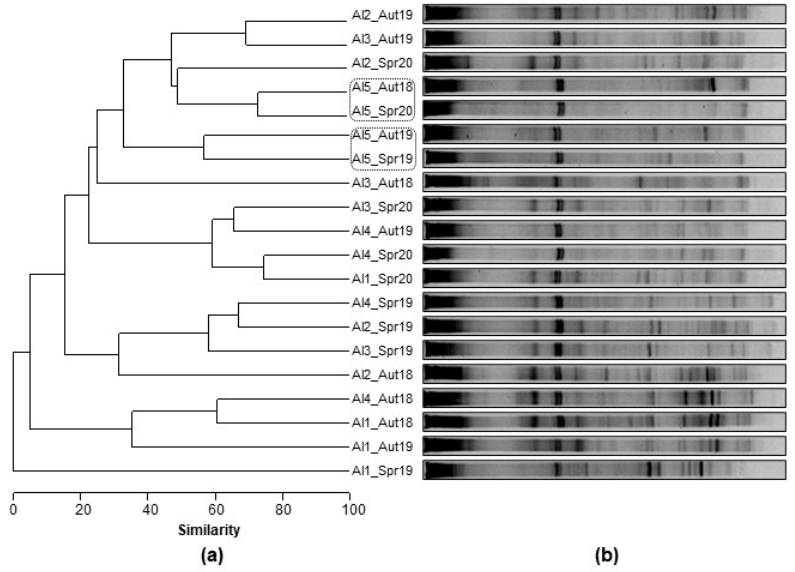
Figure 4. ( a ) Complete linkage dendrogram and ( b ) PCR-DGGE fingerprints of Alqueva (Al) bacte- rioplankton found at each sampling site (Al1, Al2, Al3, Al4, Al5) and sampling period (Aut18; Spr19; Aut19; Spr20). Aut19;